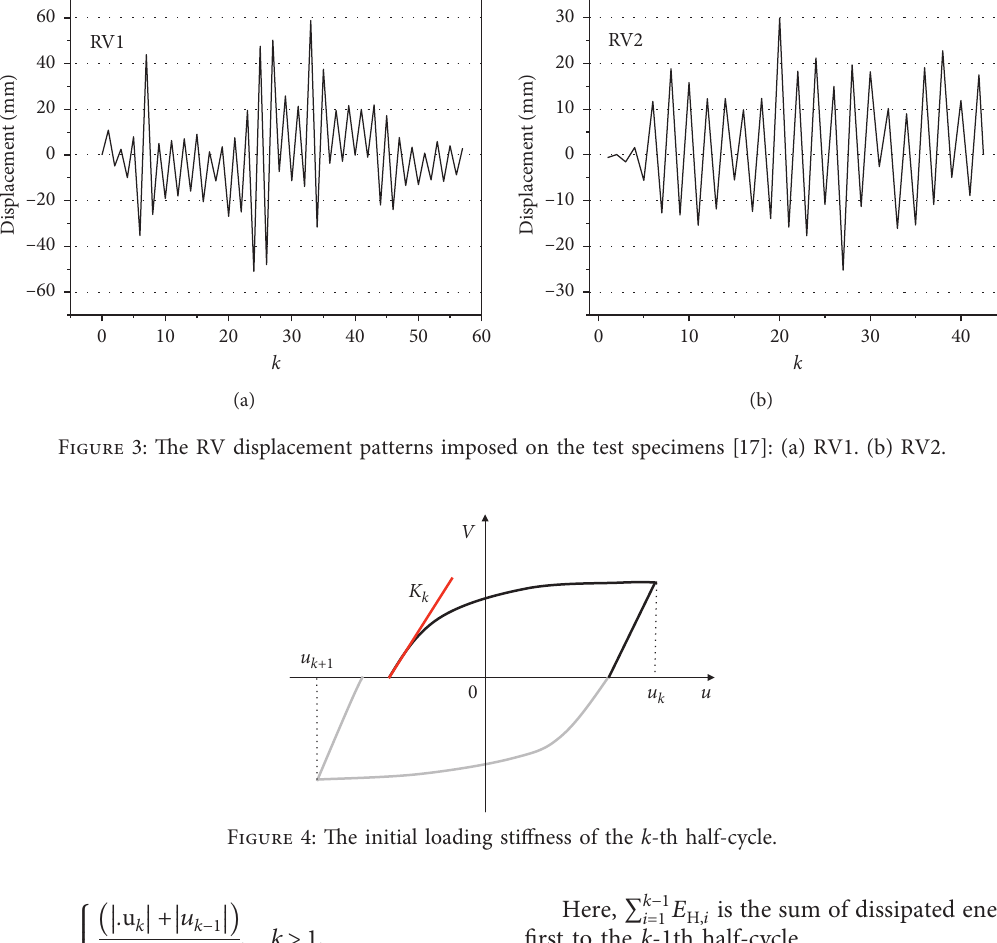
E Here, 􏽐 k − 1 is the sum of dissipated energy from the i � 1 H ,i first to the k -1th half-cycle. The D - n relations for specimens R4 to R6, R7 to R9, K, k k and R10 to R12 are shown in Figure 6. The different half- cycle sequences (HS) are represented by different symbols in Figure 6. The number next to the symbol represents the value of μ of the HS. k